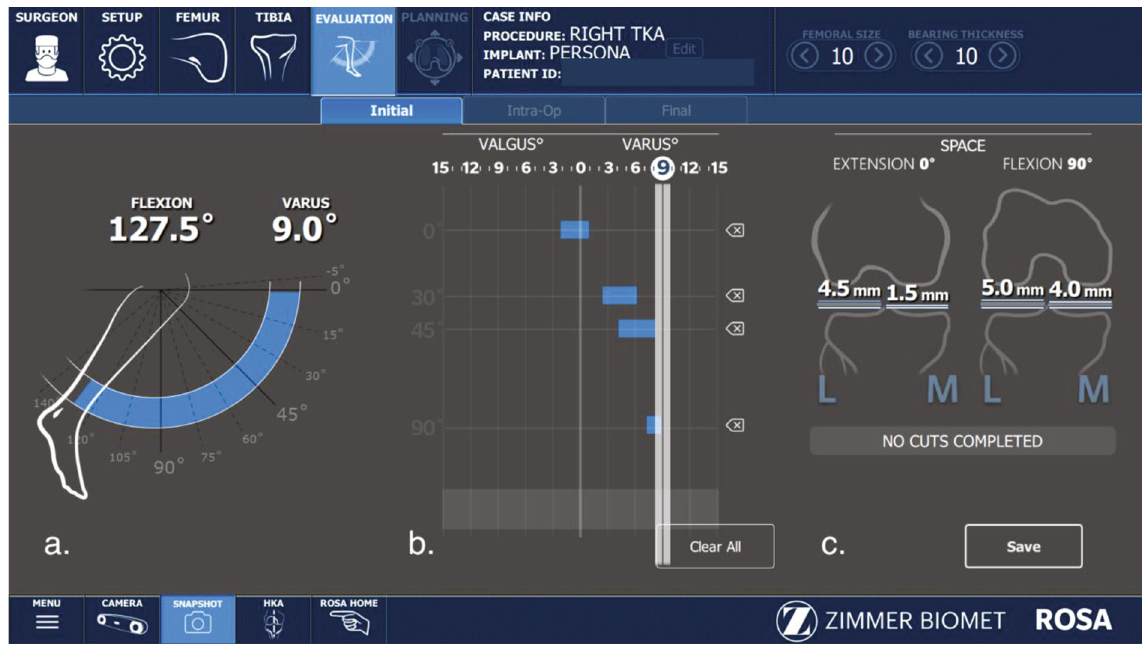
Figure 5: The robotic system ’ s knee evaluation tool in the initial stage of Case 2, which includes a preoperative evaluation of range of motion, varus/valgus alignment, and tibiofemoral joint gap spacing in fl exion and extension.